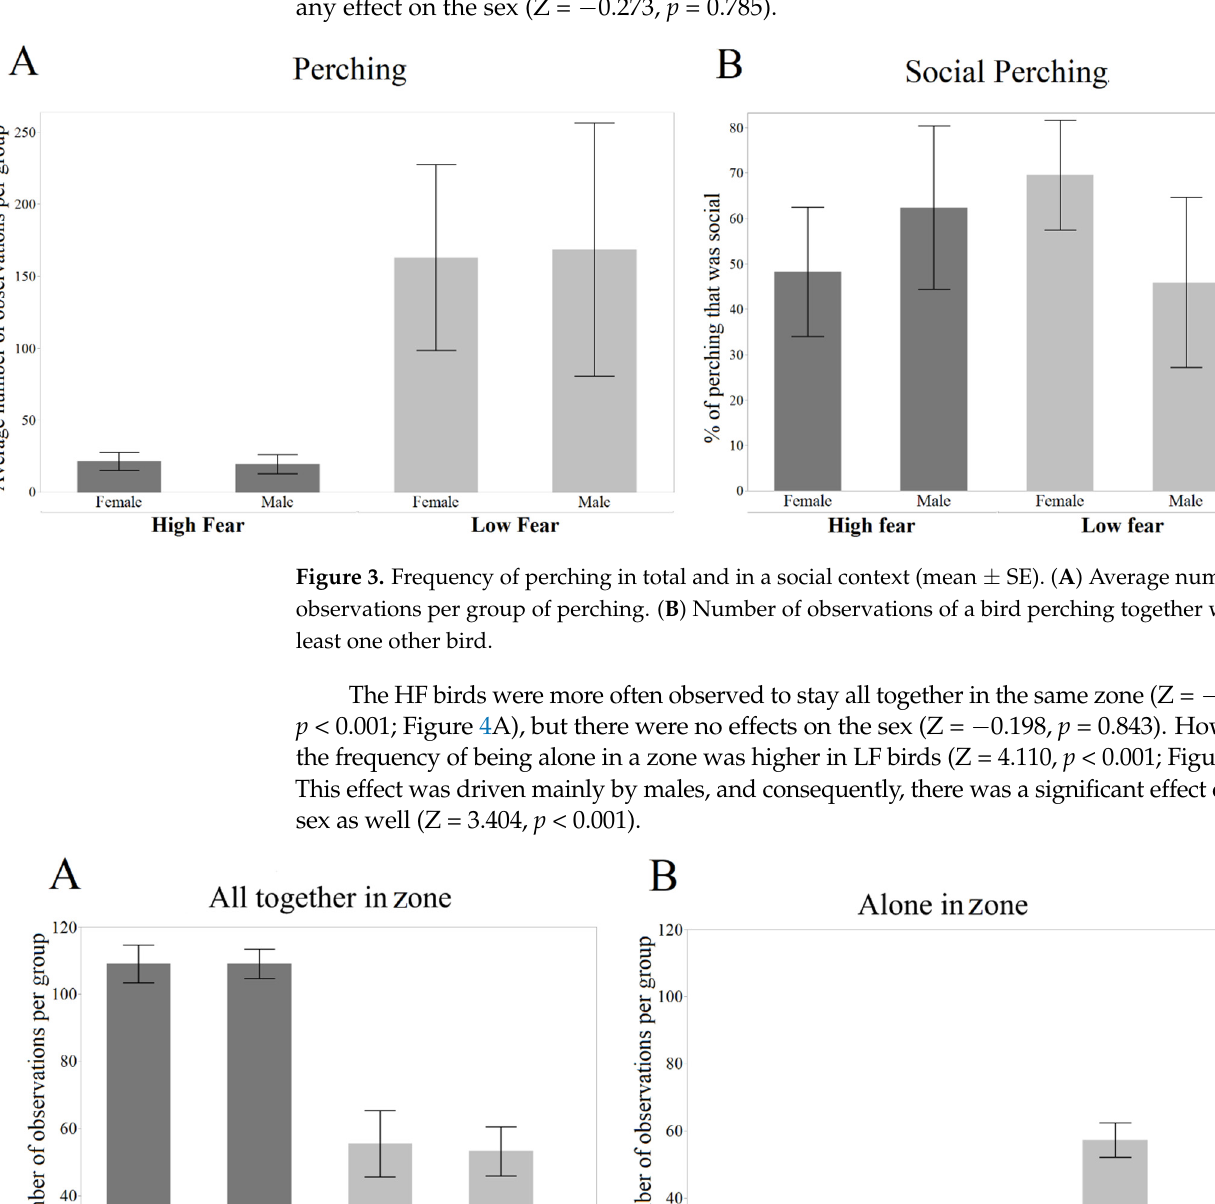
Figure 2. Frequency of agonistic behavior and non-aggressive pecking (mean ± SE). ( A ) Average number of observations per group of agonistic behavior. ( B ) Number of observations of non-aggres- sive social pecking.